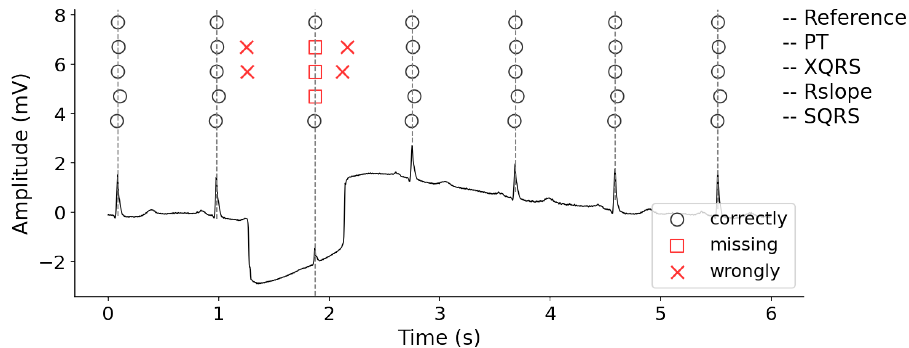
Figure 5. The R-peak detection results of 101 for different detectors on MIT-BIH database (a red X represents the wrongly identified R peak; a red rectangle is the missing R peak). TP—true positive (cor- rectly identified R peak); FN—false negative (missing R peak); FP—false positive (wrongly identified R peak); SEN—sensitivity; PPV—positive predicative value; CSI—cumulative statistical index.